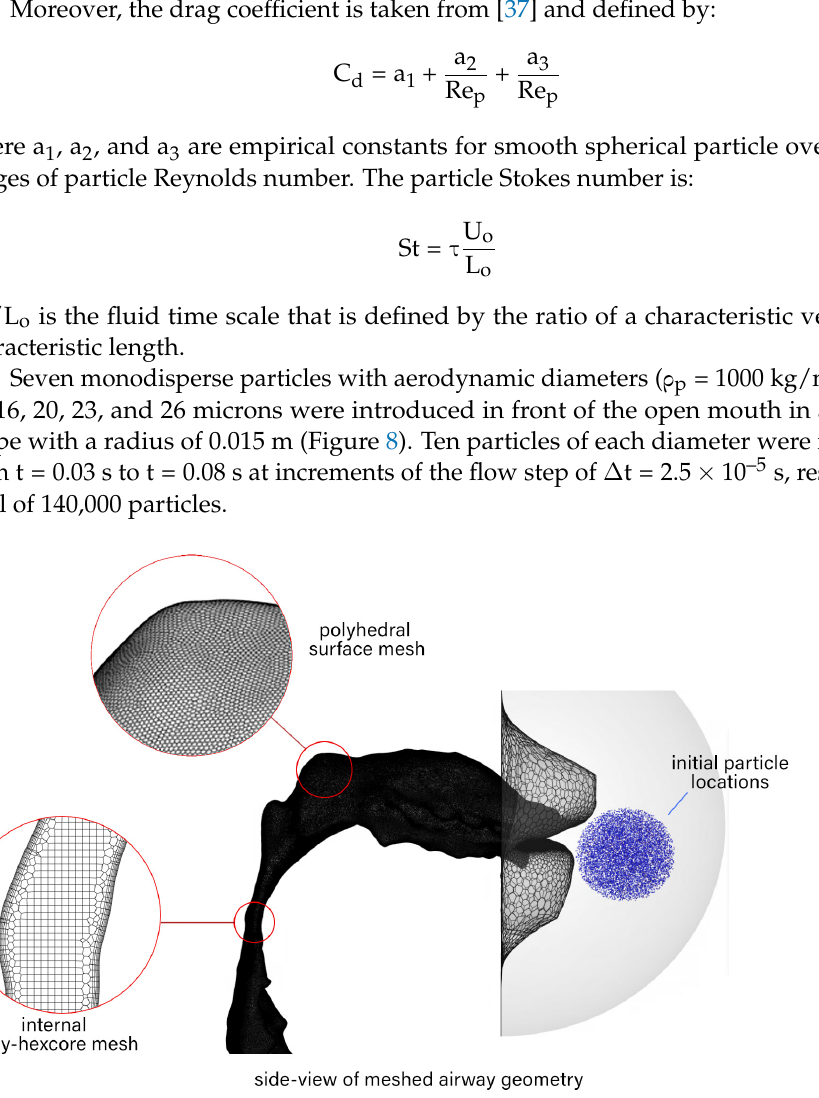
Figure 8. Side view of airway geometry depicting the surface, internal mesh, and the initial particle